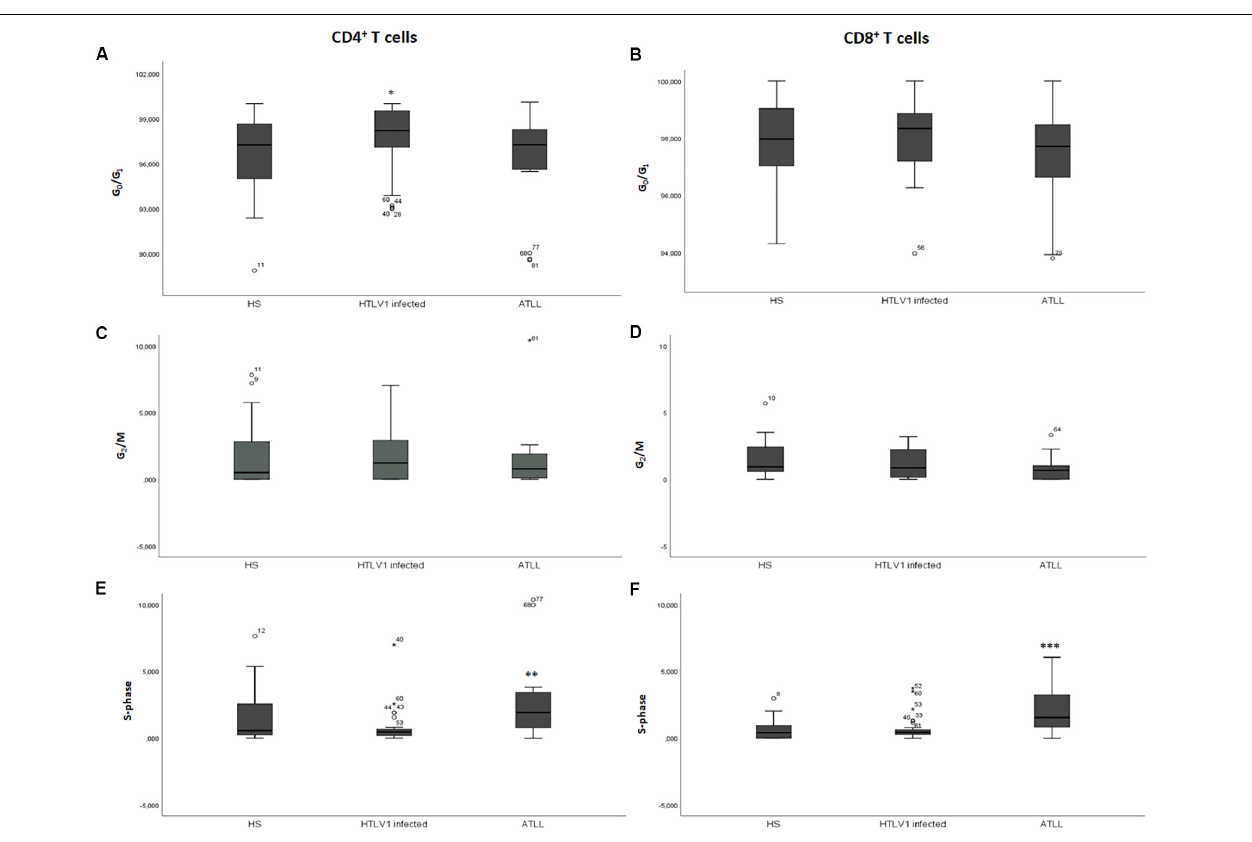
FIGURE 2 | Cell cycle analysis of CD4 + and CD8 + T cells in the different phases of cell cycle. (A,C,E) CD4 + T cells; (B,D,F) CD8 + T cells. A–B: percentage of cells in G 0 /G 1 phase; (C,D) percentage of cells in S-phase; (E,F) percentage of cells in G 2 /M phase. ∗ Cells in G 0 /G 1 phase were significantly higher in the HTLV-1 infected group in CD4 + T cells p = 0.035. ∗∗ The cells in S-phase were significantly higher in the ATL group in CD4 + T cells p = 0.003. ∗∗∗ The cells in S-phase were significantly higher in the ATL group in CD8 + T cells p = 0.003. HS, Health subjects; HTLV-1 infected, HTLV-1 Asymptomatic carriers; ATL, Adult T-cell leukemia/lymphoma. The data represents the median, the minimum and maximum value of the cell cycle phase; between the minimum and maximum values, is the interquartile